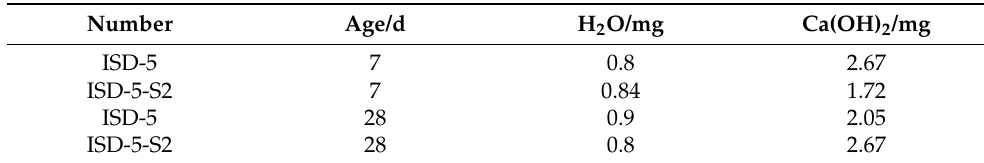
Table 5. Gel water and Ca(OH) 2 content of ISD systems.